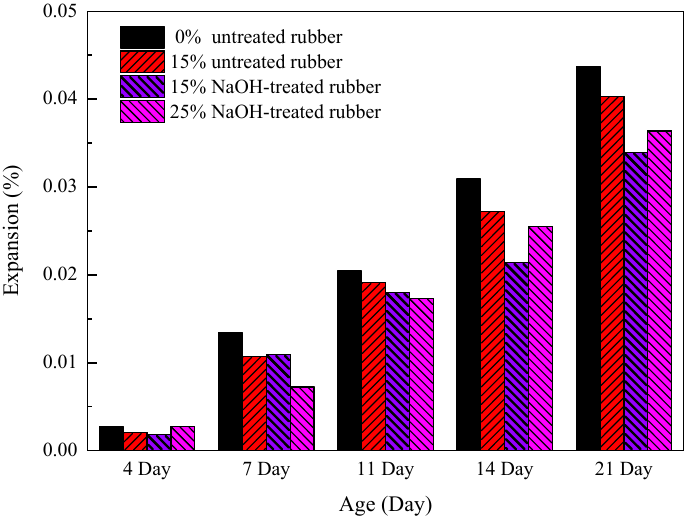
Figure 13. ASR expansion of different types of SCM at different ages [89].